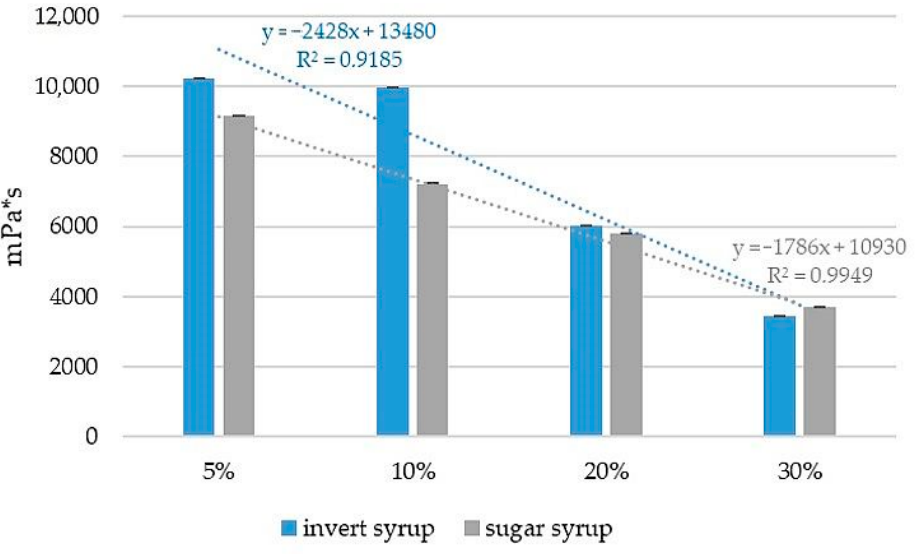
Figure 1. Linear dependence between viscosity and content of sugar syrup in liquid phase of adulterated honey.